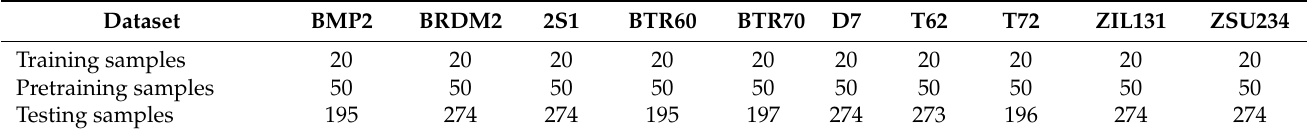
Figure 10. Weaken fusion result ( a ) BTR60 original; ( b ) the fusion ratio is 1:5; ( c ) the fusion ratio is 1:10; ( d ) the fusion ratio is 1:15; ( e ) the fusion ratio is 1:20; ( f ) the fusion ratio is 1:25. The testing dataset is created by selecting a sample from the MSTAR dataset. The pre-training samples, the training samples, and the testing sample are listed in Table 1.